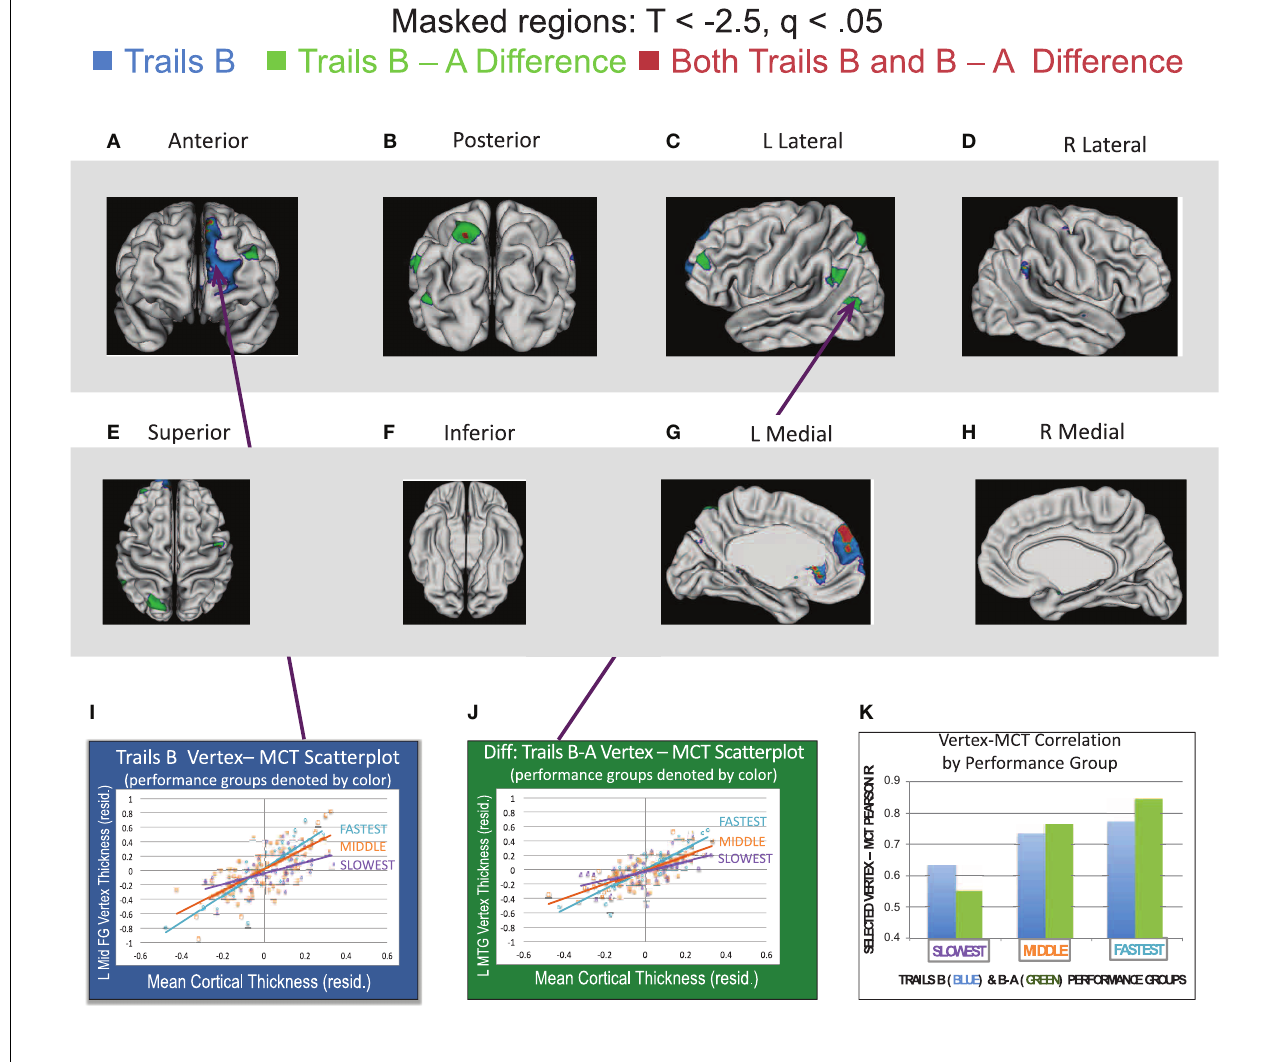
FIGURE 1 | Regions associated with greater cross-cortical coupling for those with stronger performance on Trails B, the Differences between Trails B and A, and Both Trails B and the B–A Difference. Two sets of linear regression analyses predicting cortical thickness at each vertex in both hemispheres were run in the complete sample ( n = 146) of participants in order to evaluate if coupling between mean cortical thickness (MCT) and vertex thickness varied as a function of individual differences in either (1) Trails B time (age-adjusted) or (2) the difference in time between Trails B and A (age-adjusted). The regression equations were as follows. (1) For Trails B time: Cortical thickness (vertex j) = Intercept + ß 1 (MCT) + ß 2 (Trails B time) + ß 3 (MCT ∗ Trails B). (2) For the Difference in time for Trails B vs. Trails A: Cortical thickness (vertex j) = Intercept + ß 1 (MCT 1 ) + ß 2 (Trails B–A time) + ß